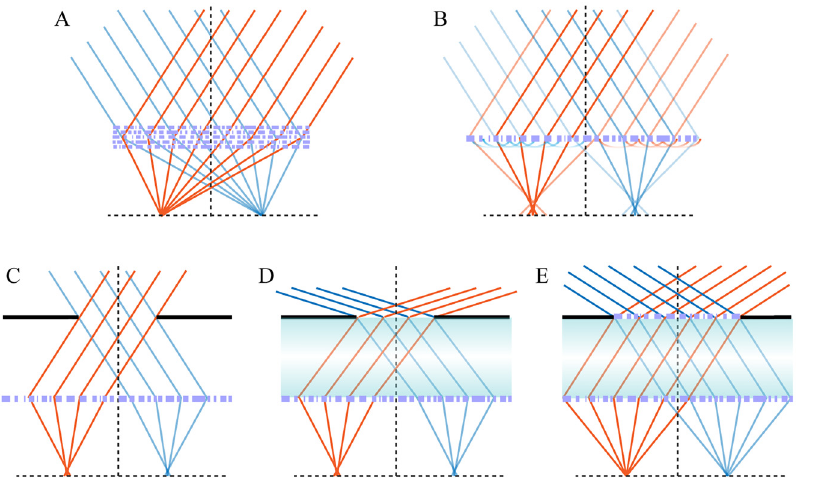
Figure 2: Schematic diagrams of several basic configurations for sing-chip wide-angle metalenses. The red and blue lines represent the light rays with different incidence angles. (A) Optimized multi-parametric geometries. (B) Monolayer quadratic metalens. (C) Landscape quadratic metalens using an air gap. (D) Landscape quadratic metalens using a dielectric gap. (E) Metalens